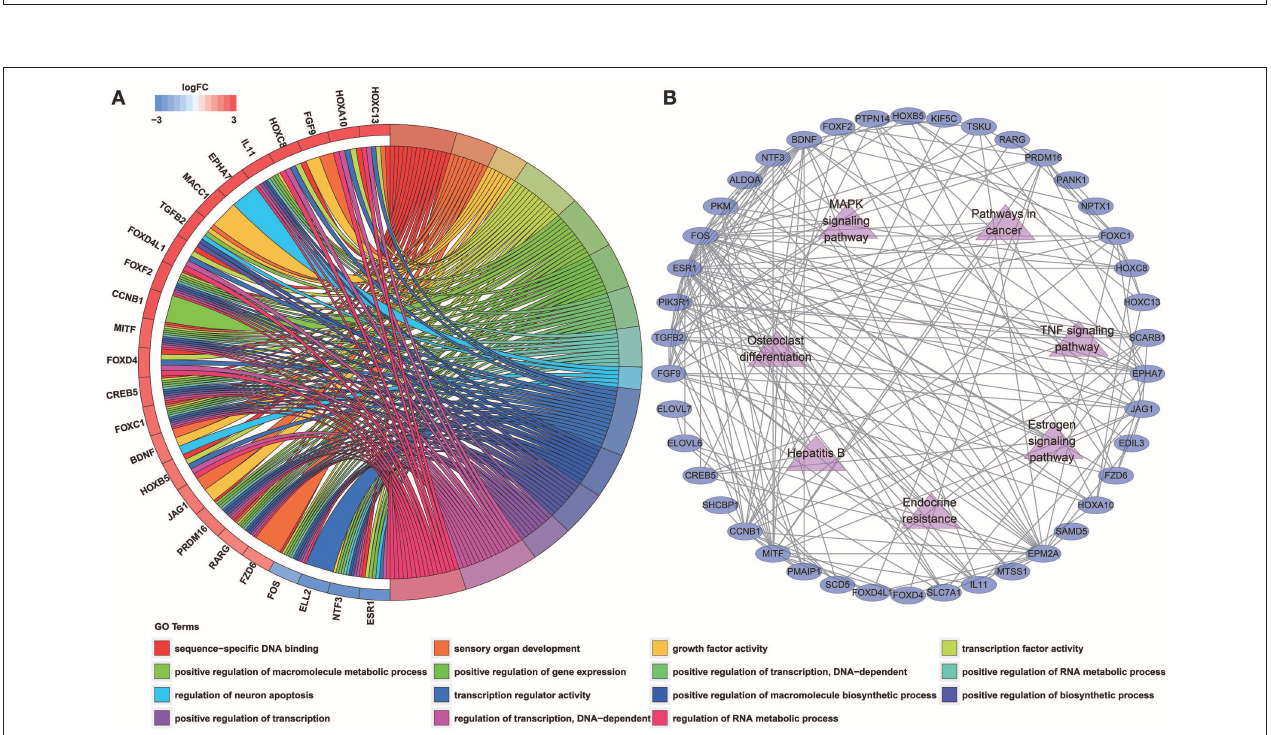
FIGURE 3 | Functional enrichment analysis of 60 DEmRNAs . (A) Chord diagram showing enriched GO clusters for the 60 DEmRNAs. In each chord diagram, genes contributing to their respective enrichment are shown on the left, and enriched GO clusters are shown on the right. Downregulated DEmRNAs are displayed in blue, whereas upregulated DEmRNAs are displayed in red. Each GO term is represented by one colored line. (B) PPI networks of the DEmRNAs. Ellipse represents DEmRNA, and edge represents the interaction between two proteins. Triangles represent pathways in which 60 DEmRNAs were enriched.